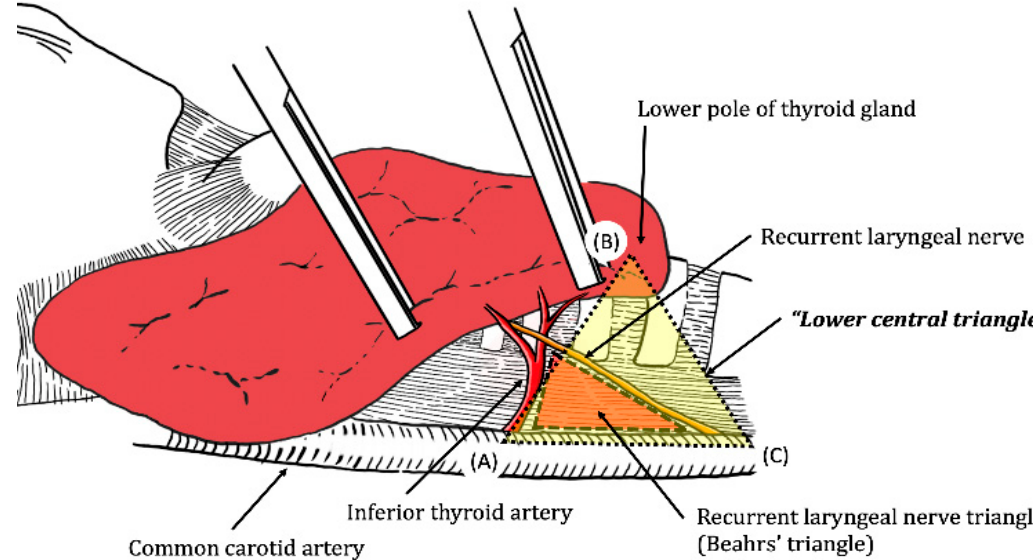
Figure 1. The constituents of lower central triangle (LCT). Viewed at the right lobe of thyroid with the lower pole of thyroid gland lifted.